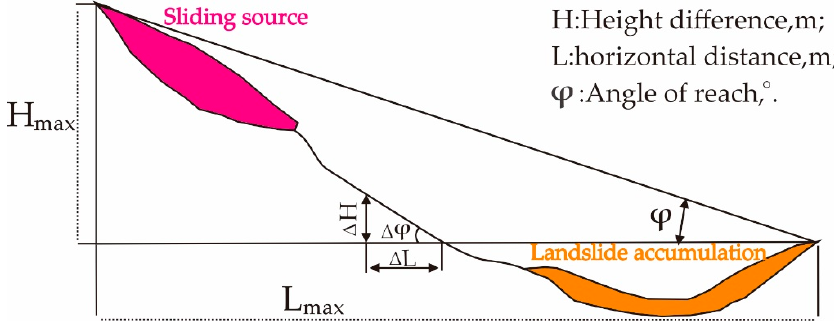
Figure 11. Sketch of the Empirical-statistical model (It is modified from [19]).